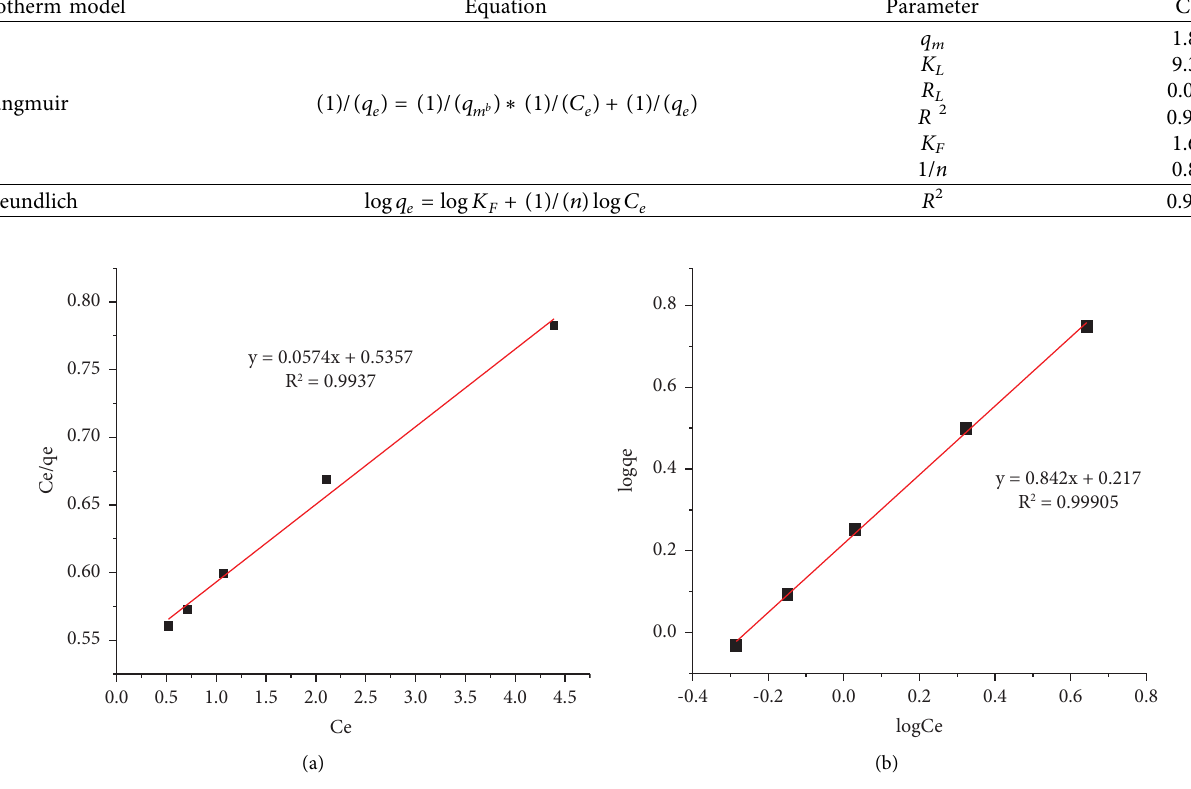
Figure 12: Isotherms models of (a) Langmuir and (b) Freundlich for the adsorption of fuoride onto HAp NPs. Table 2: Nonlinear sorption isotherm model equation, parameter, and error function data.